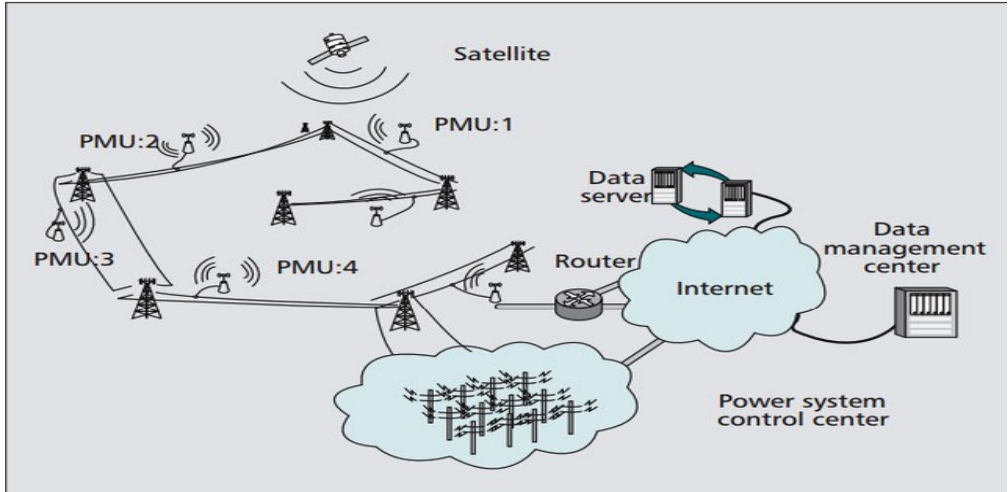
Figure 4. Hierarchical structure of a Wide Area Measurement System with PMUs.